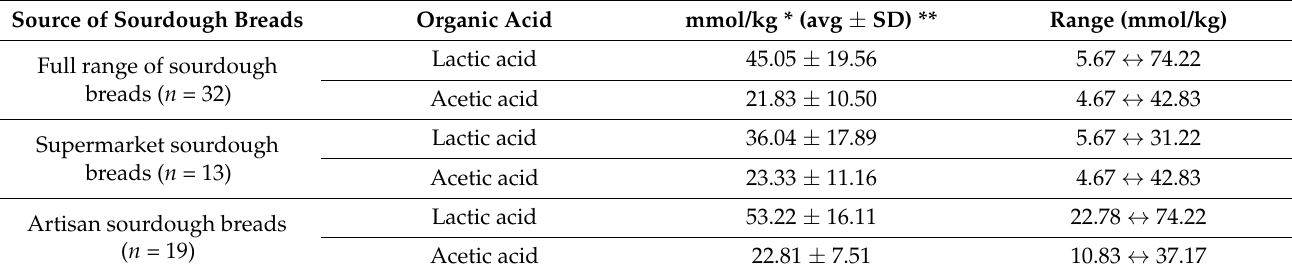
Table 3. Lactic acid and acetic acid content in the crumb of commercial sourdough breads.